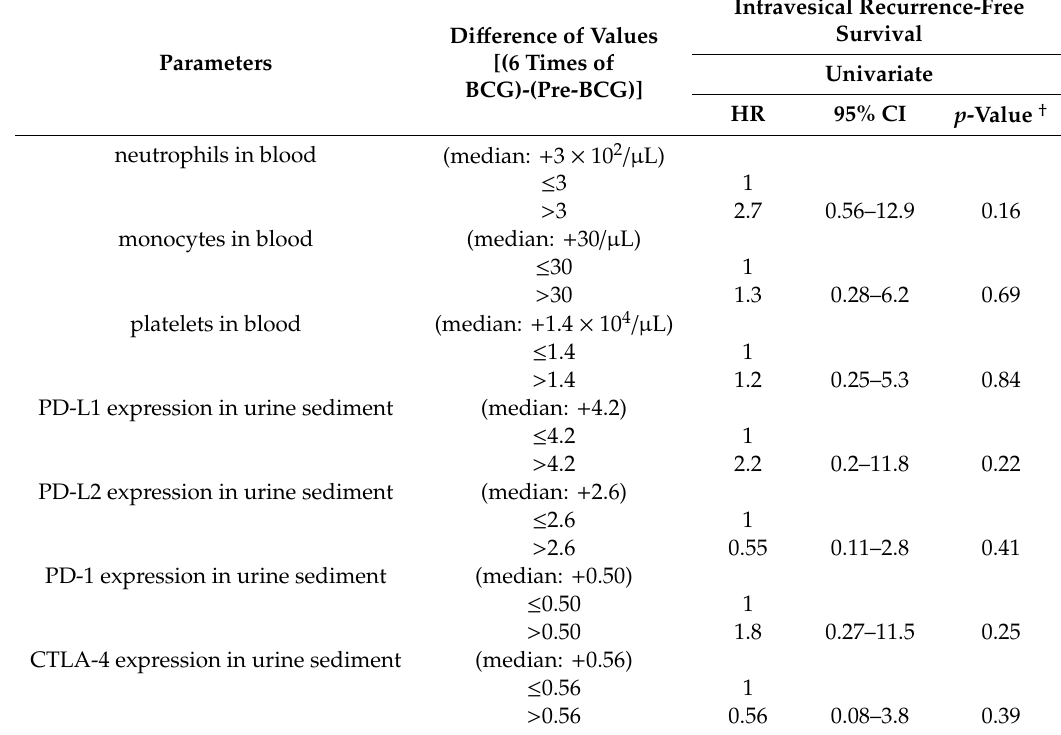
Table 4. The prognostic factors for recurrence in 24 patients treated with intravesical